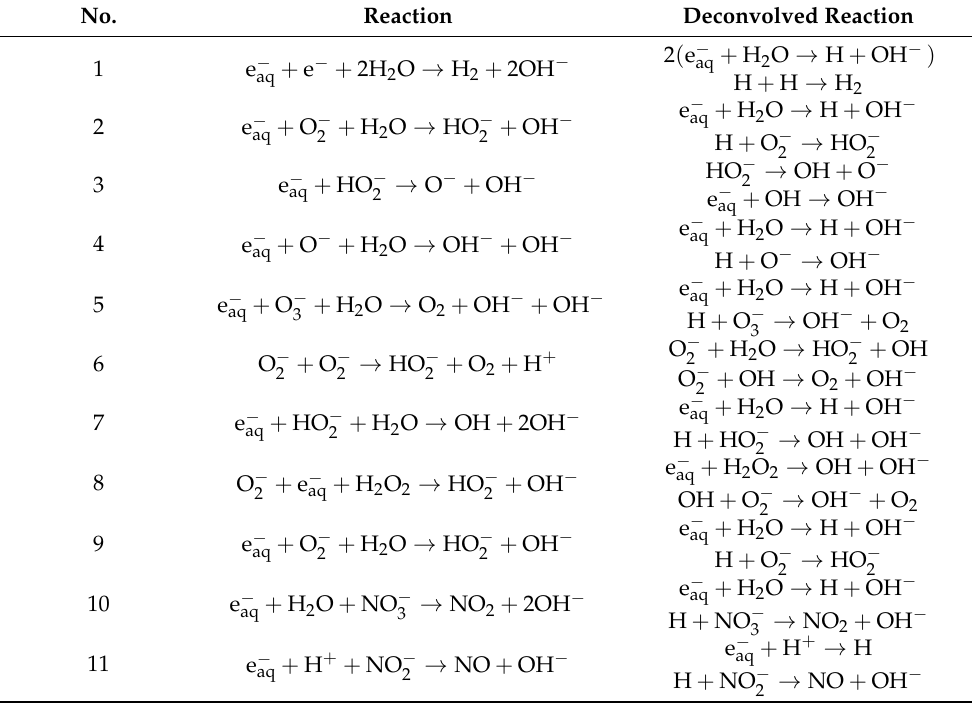
Table 7. Deconvolution of nonviable reactions listed in Table 6 into elementary reactions. No. Reaction